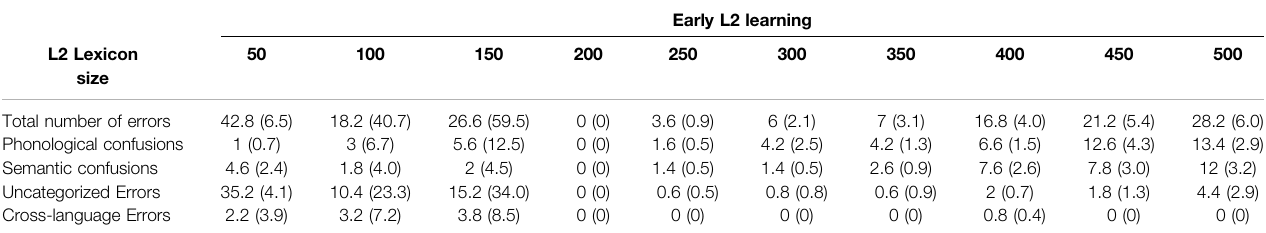
TABLE2| NumberofeachtypeofcomprehensionerrorsinL2(English)acrossdifferentearlyL2learningstages.Resultsaveragedover5simulationsforeachlearningstage. Standard deviations are listed within the parentheses.